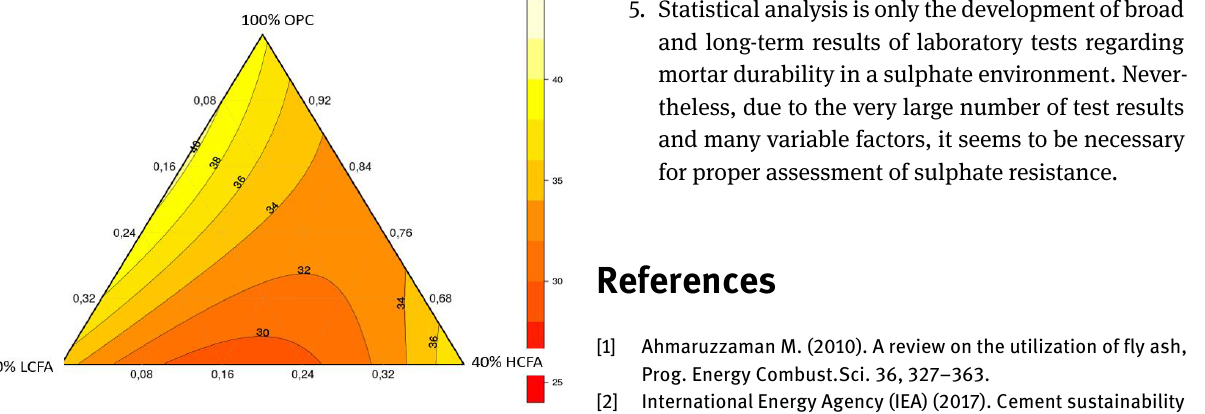
dicted level of the dependent variable depending on the composition of the mortar (Figure 8). Analyzing thecontour diagrams, Thesmaller values of linear strain around the centroid, i.e. for mortars in which part of the cement was replaced by a mixture of fly ash (26.6% and 40%) and the region around 40% HCFA were